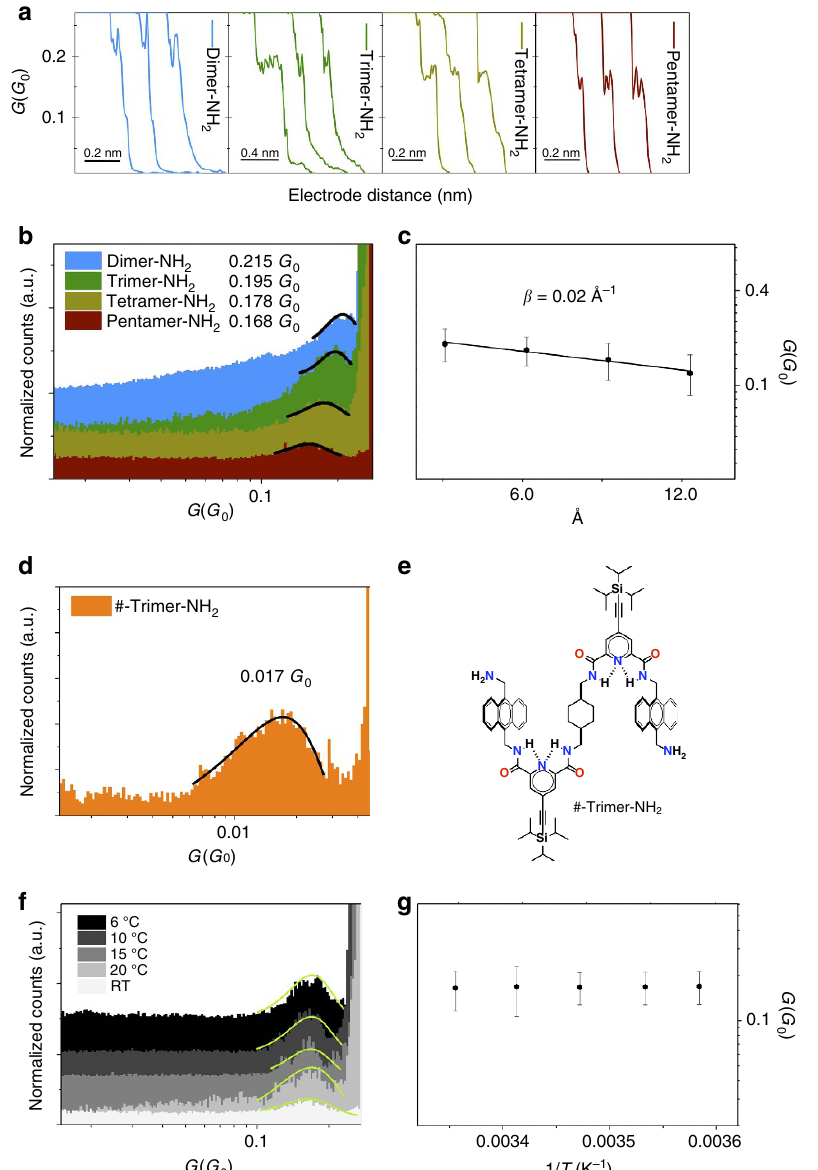
Figure 5 | Single-molecule conductance measurements. ( a ) Individual pulling traces and ( b ) conductance histograms of the different foldamers. All conductance values were extracted from Gaussian fits. ( c ) Calculated (cid:2) value for the p – p foldamers. Error bars capture the variability in peak position. ( d ) Conductance histograms for #-trimer-NH 2 . ( e ) Structure of #-trimer-NH 2 . ( f ) Conductance histograms for the pentamer-NH 2 at variable temperatures. ( g ) Arrhenius plot of the single-molecule conductance for the pentamer-NH 2 . Error bars represent the s.d. of the experimental conductance values extracted from the full width at half maximum of the Gaussian fits. Applied voltage bias were 5mV for the trimer-NH 2 –pentamer-NH 2 series and 50mV for dimer-NH 2